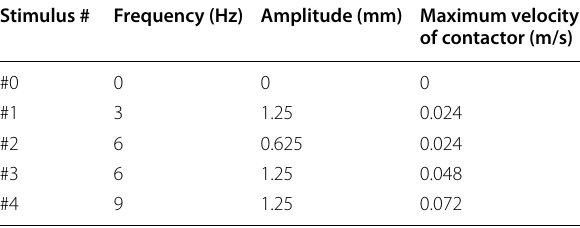
Table 2 Vibratory stimuli used in the simulation and psy- chophysical